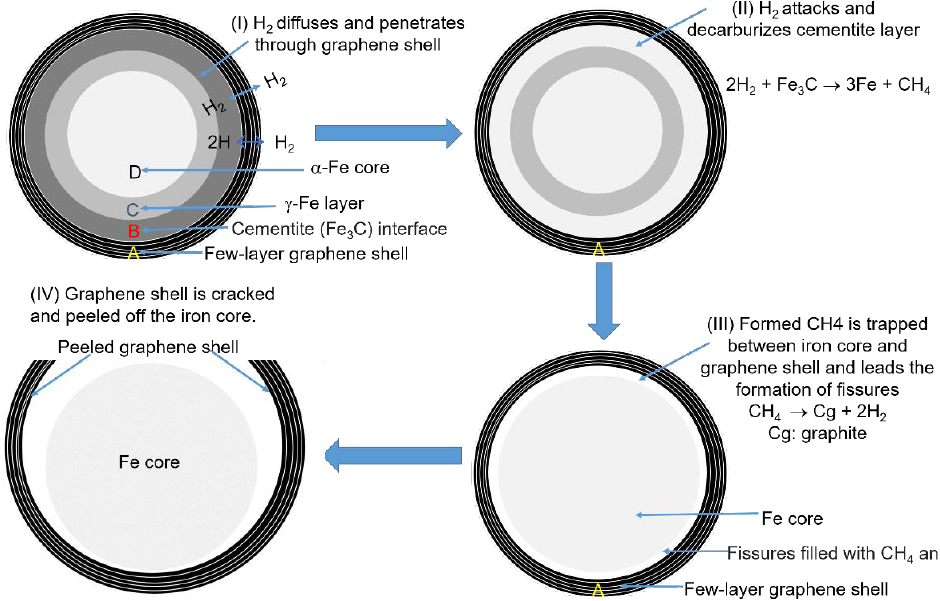
Scheme 2. Scheme of possible cracking and peeling mechanism of GEINs by hydrogen through a heating